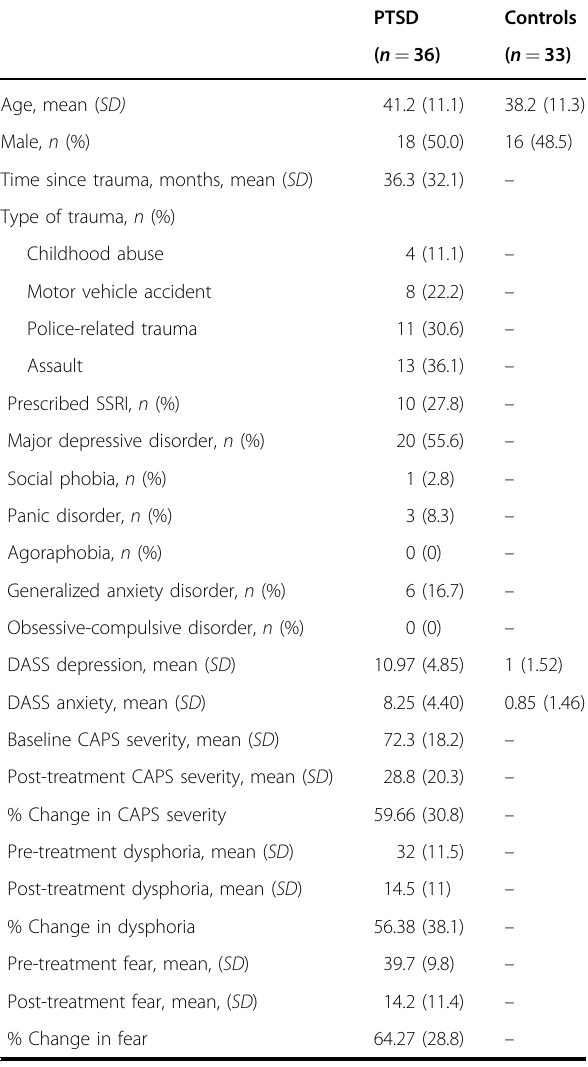
Table 1 Participant